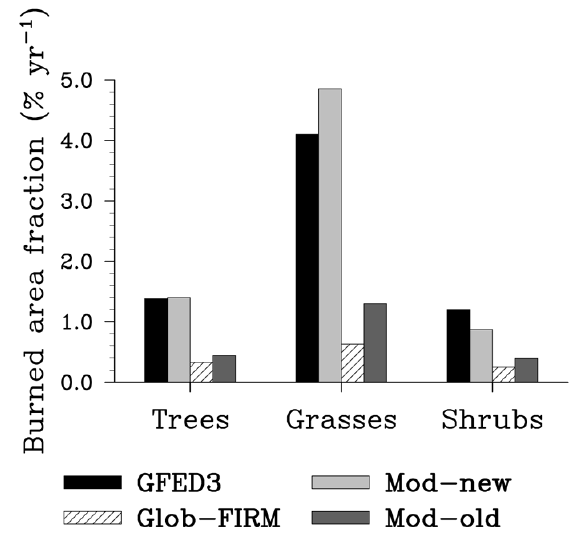
Fig. 10. 1997–2004 mean annual global burned area fraction of var- ious natural vegetation types for GFED3 and CLM-DGVM simula- tions with different fire